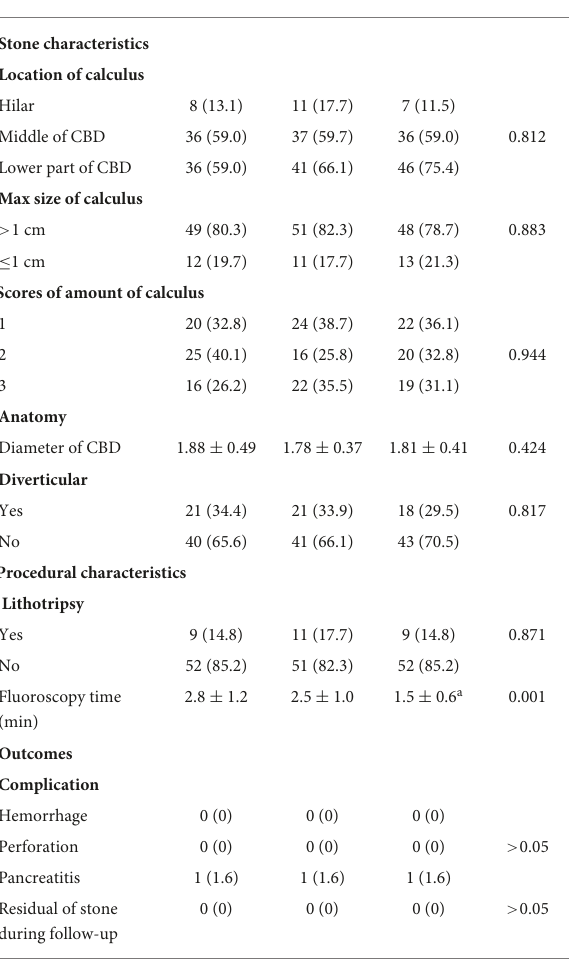
TABLE 2 Baseline stone characteristics, procedural characteristics, anatomy, and